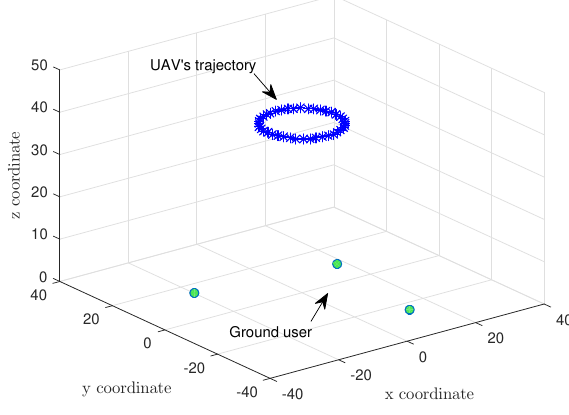
Figure 5. The network topology. Table 2. Simulation